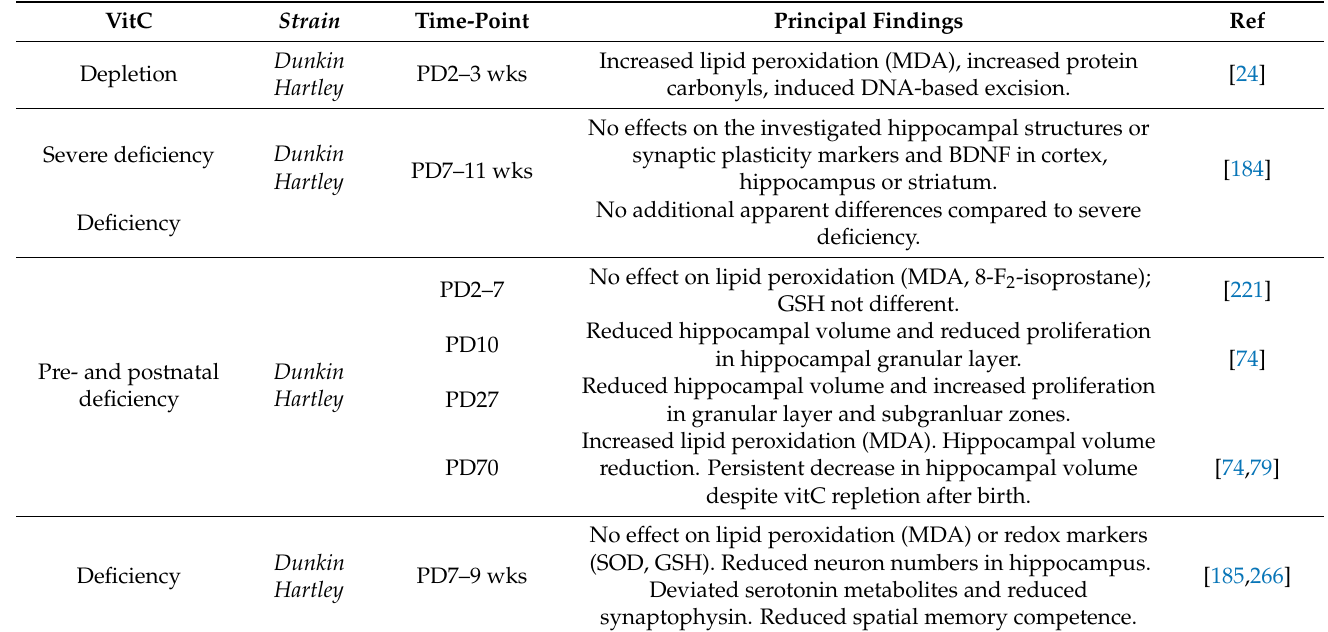
Table 3. Principal findings of postnatal vitamin C deficiency in the brain—findings from guinea